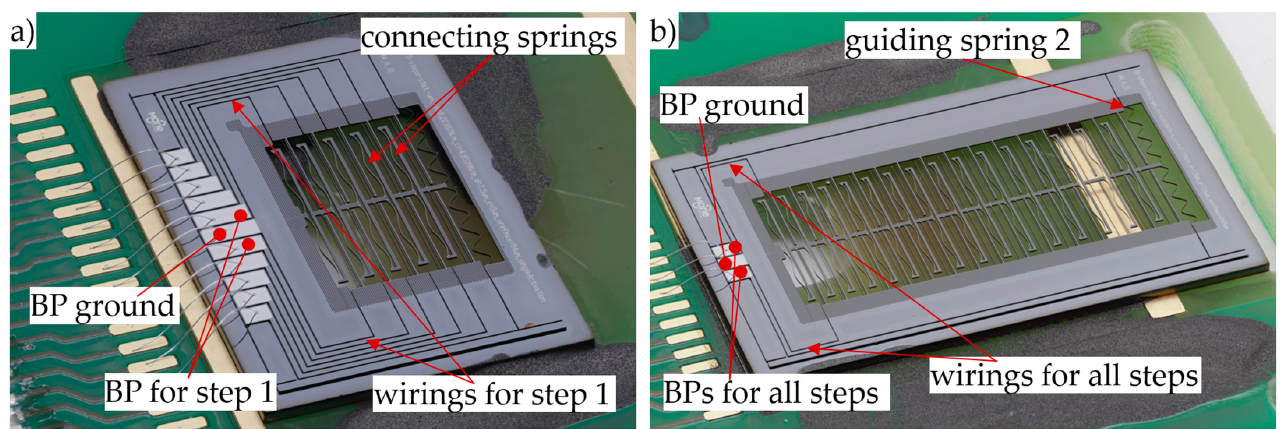
Figure 3. ( a ) 5-step system (system 2) for step-by-step and collective actuation, ( b ) 16-step system (system 6) for collective actuation, (stacked device photos).